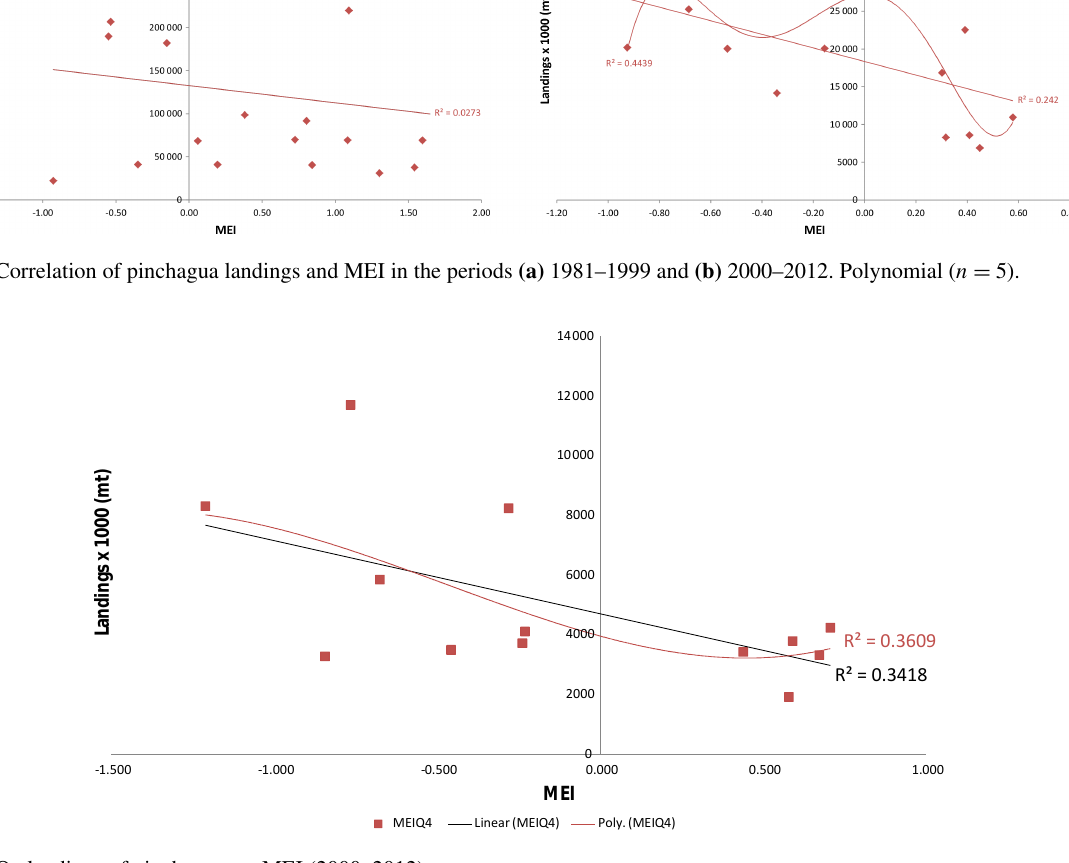
Figure 14. Q 4 landings of pinchagua vs. MEI